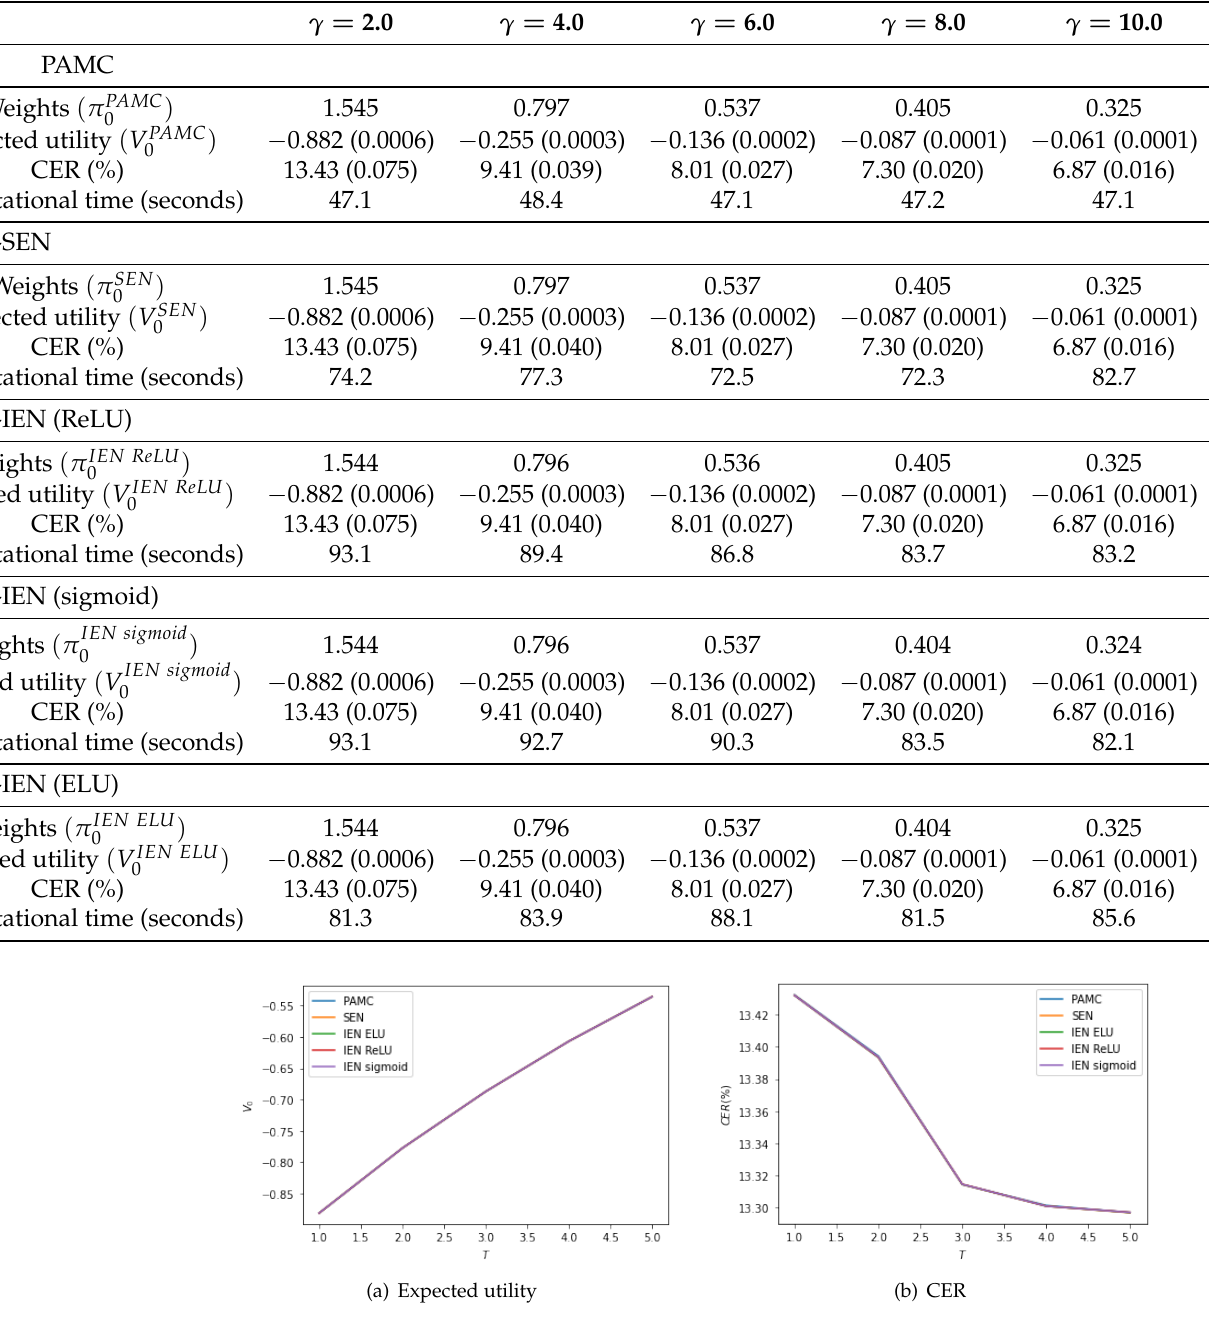
Figure 4. S t follows a 4/2 model with stochastic jump, where ( a ) shows the expected utilities obtained with the approximation methods versus investment horizon T ; and ( b ) shows CERs versus investment horizon T given γ =